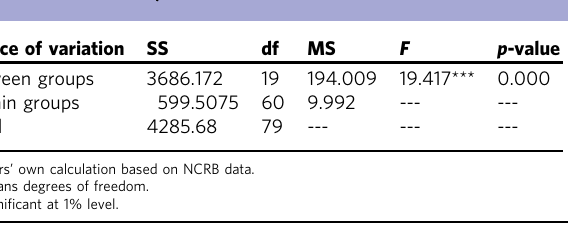
Table 5 Inter-state variations in the reported POCSO cases across Indian states,